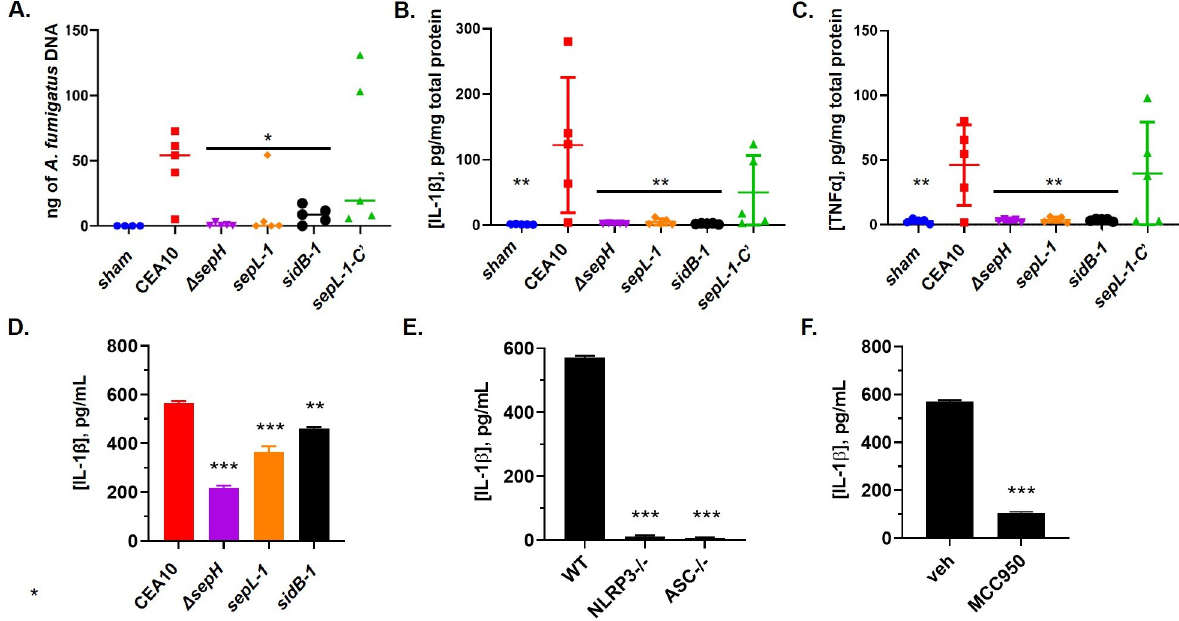
Fig 9. Loss of virulence in the SIN kinase mutants is characterized by decreased fungal burden and host response to infection. A) Analysis of fungal burden by qPCR at day +4 post inoculation. Mice (n = 5 / group) were immune suppressed with cyclophosphamide and triamcinolone acetonide and inoculated with 1x 10 6 conidia from each strain. Data are represented as nanograms of A . fumigatus specific DNA in 500 ng of total DNA. � p < 0.02. Quantitation of IL-1 β (B) and TNF α (C) revealed decreased host response in SIN kinase mutant infected mice. Mice (n = 5 / group) were immune suppressed as indicated for fungal burden analysis and lung tissue was removed at day +4 post-inoculation, homogenized and analyzed by ELISA. �� p = 0.0024 for (B); �� p = 0.0031 for (C). An in vitro IL-1 β release assay uncovered decreased induction of inflammasome activation by the SIN kinase mutants. D) Conidia from each strain were co-incubated with phorbol 12-myristate 13-acetate (PMA)- activated THP-1 cells (MOI 10:1) for 16 hrs and supernatants analyzed by ELISA for IL-1 β concentration. ��� p < 0.0001; �� p = 0.0014. E) Inflammasome dependence of IL-1 β release was established by co-culturing PMA-activated WT (THP1-null), Nlrp3 − / − (THP1-KO-NLRP3), and Asc − / − (THP1-KO-ASC) THP-1 cells with CEA10 conidia (MOI 10:1) as indicated for (D). ��� p < 0.0001. F) Inflammasome dependence of Aspergillus - induced IL-1 β release was further confirmed by repeating this assay in the presence of the inflammasome inhibitor, MCC950 (10 μ M). ��� p < 0.0001. All experiments were conducted in technical replicates ( n = 4) and repeated independently in triplicate. Statistical comparisons in (A), (B), (C), and (D) were made by one-way ANOVA with Dunnett’s multiple comparisons test post hoc and represent comparison of each SIN kinase mutant to the CEA10 control. Statistical comparisons in (E) were made by one-way ANOVA with Dunnett’s multiple comparisons post hoc and represent the NLRP3-/- and ASC-/- versus WT control. The statistical comparison of MCC950 versus vehicle in (F) was made by unpaired